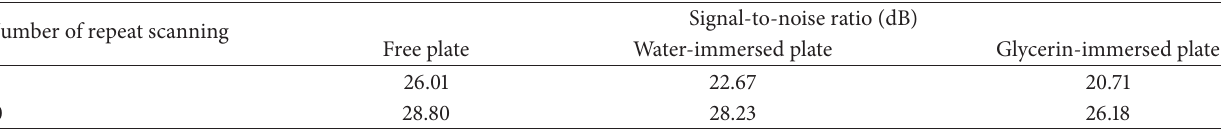
Table 1: SNR comparison related to immersion and repeat scanning.